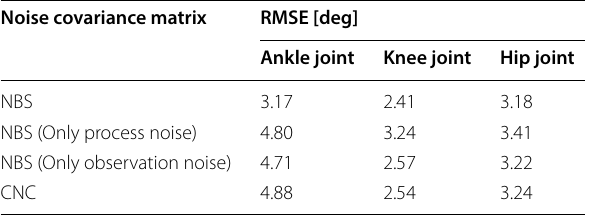
Table 3 Root mean square errors for results obtained from two extended Kalman filters and 3D motion analysis system results (participant